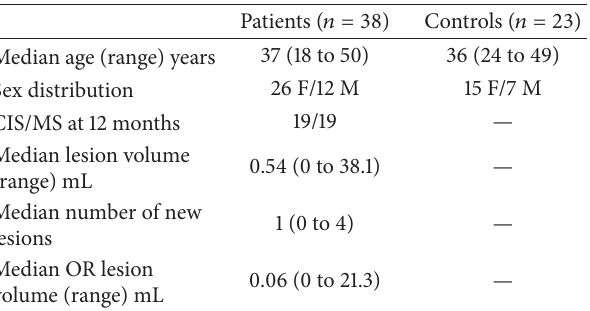
Table 1: Demographic and disease summary data for acute ON patients and healthy